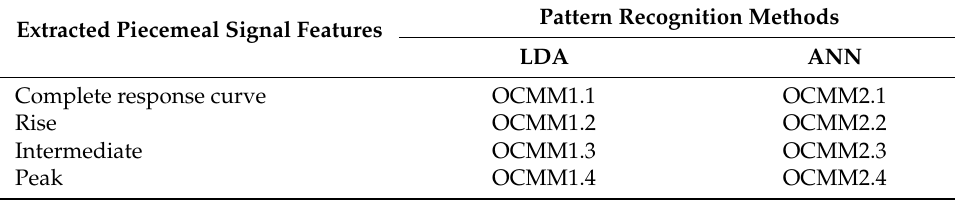
Table 7. Matrix of the different elaborated and compared odour classification monitoring models